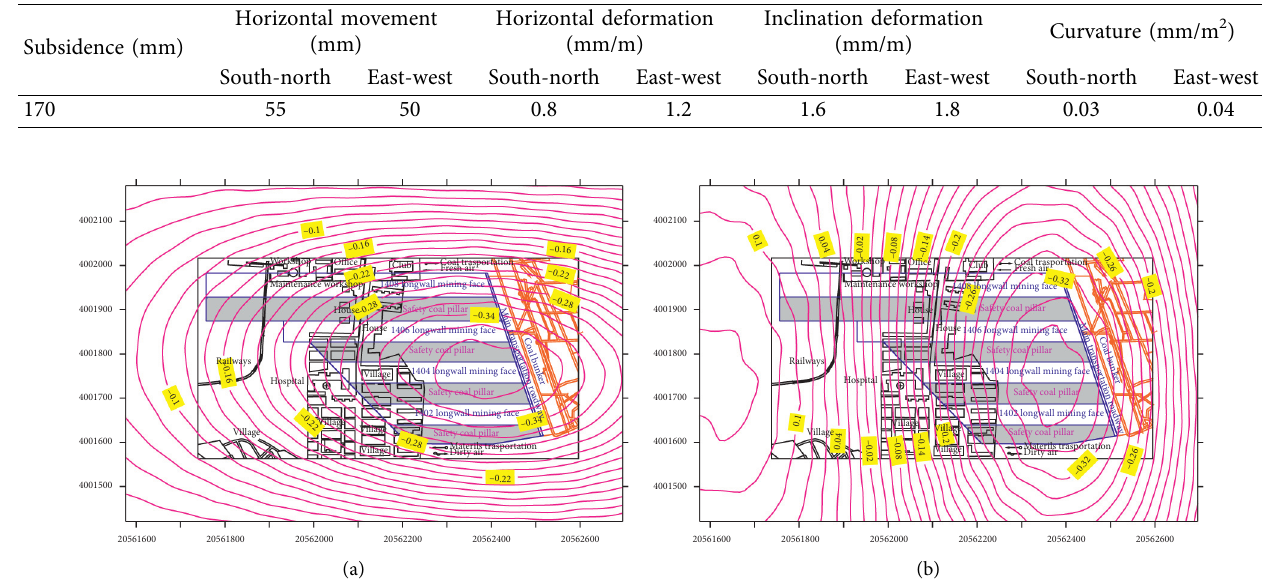
Table 2: Surface movement and deformation extrema in RMCPB.